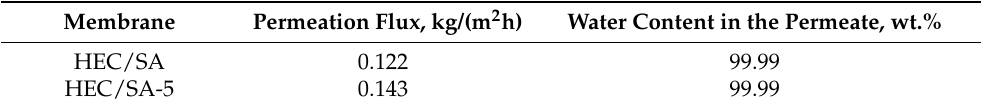
Table 3. Transport parameters of the HEC/SA and HEC/SA-5 membranes in pervaporation separa- tion of the azeotropic water (12 wt.%)–isopropanol (88 wt.%) mixture at 22 ◦